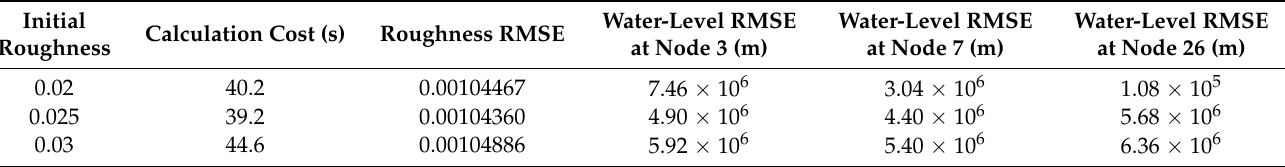
Table 3. RMSE of roughness and water level at Nodes 3, 7, and 26 with different initial roughness